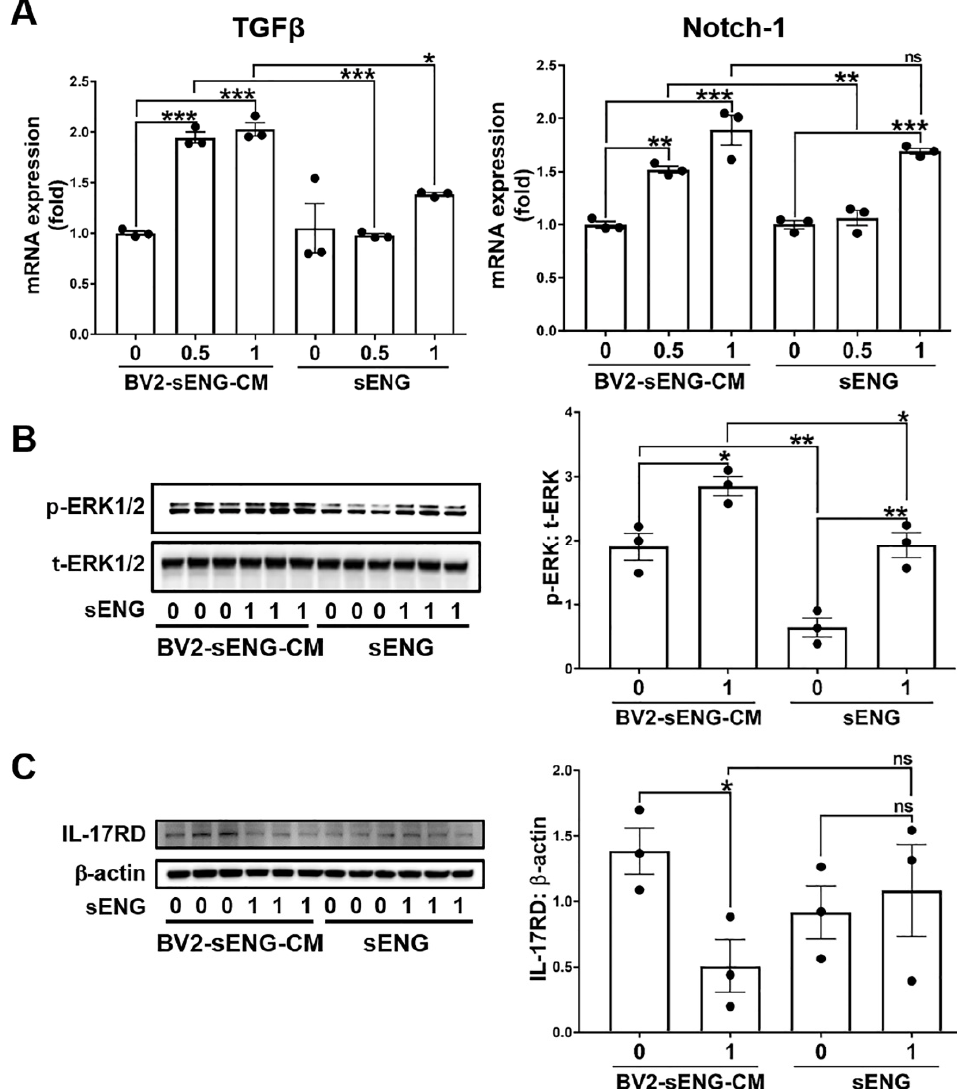
Figure 4. Soluble ENG-stimulated microglia regulate the expression of angiogenic mediators in endothelial cells. ( A ) Gene expression of angiogenic mediators in ECs treated with sENG (0.5 or 1 µ g/mL)-treated microglia conditioned medium (BV2-sENG-CM). Mouse brain vascular endothelial cells (ECs) were incubated in a medium containing BV2-CM, BV2-sENG-CM, PBS, or sENG for 24 h. Data are presented as mean ± SEM; * p < 0.05, ** p < 0.01, *** p < 0.001; one-way ANOVA. ( B ) BV2-sENG-CM or sENG induced p-ERK1/2 expression in ECs. n = 3; data are presented as mean ± SEM; * p < 0.05, ** p < 0.01; one-way ANOVA. ( C ) BV2-sENG-CM decreased IL-17RD expression in ECs. n = 3; data are presented as mean ± SEM; * p < 0.05; one-way ANOVA.